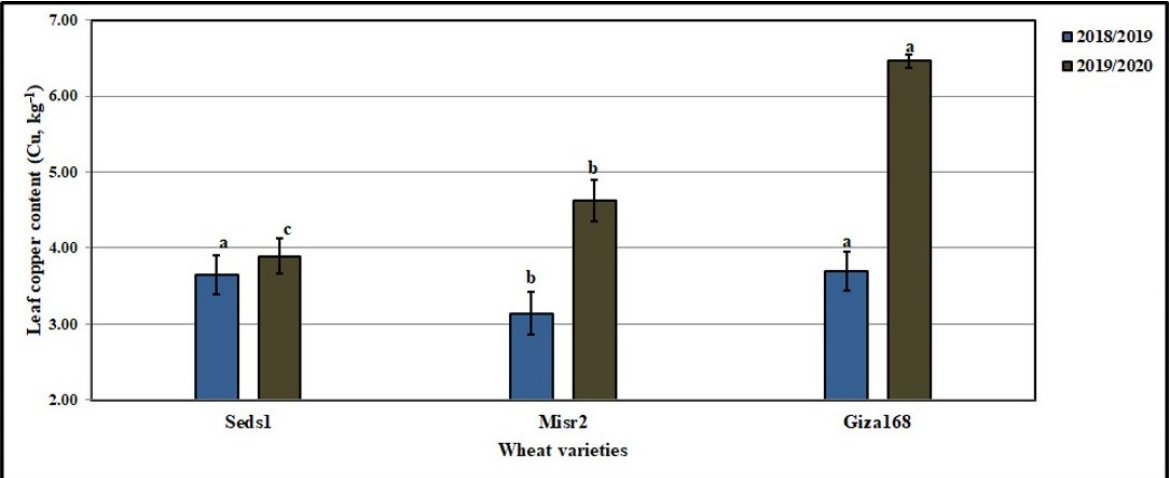
Figure 32. Influence of wheat varieties on leaf copper contents (Cu, mg kg − 1 ) in clay loam soil in 2018/2019 and 2019/2020 seasons. Bars in the same years with a different letter indicate significant differences between treatments at p ≤ 0.01. HS 1, HS 2 , HS 3 represent HS applied as foliar spray at 1.0, 2.0, 4.0 g L − 1 , respectively, HS 4 , HS 5 , HS 6 represent HS applied as soil application at 5.04, 7.56, 10.08 kg ha − 1 .